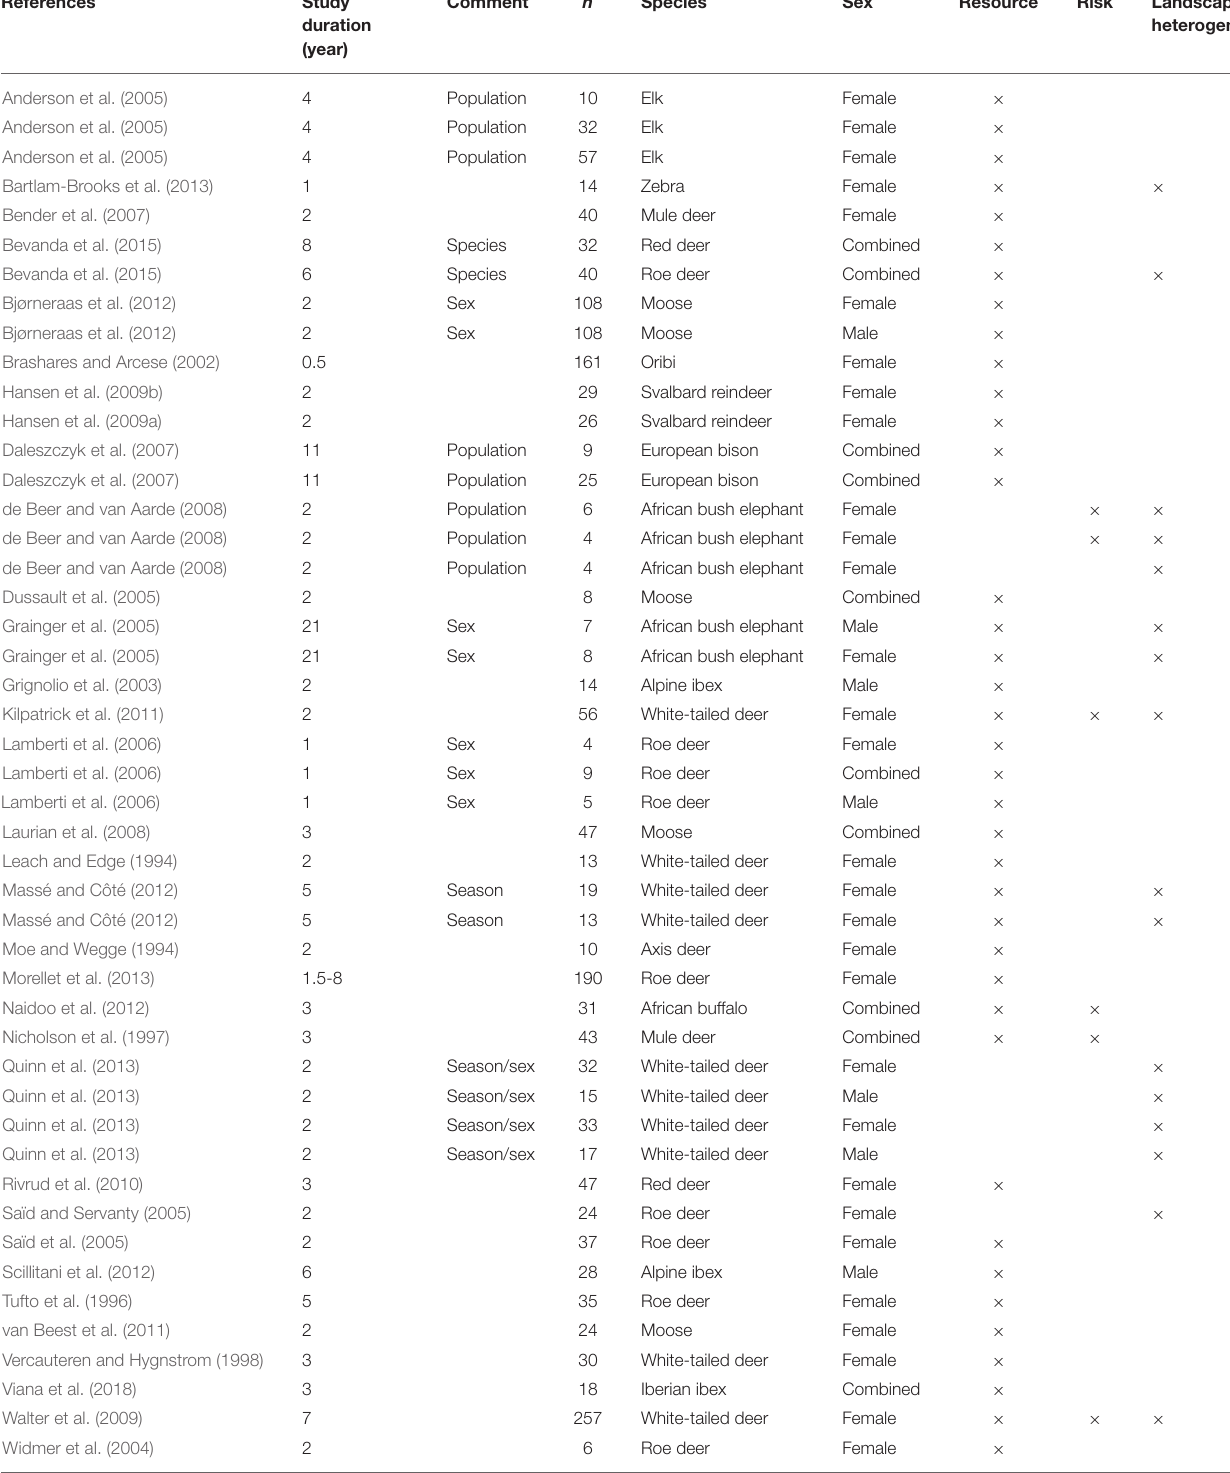
TABLE 1 | Information on the 33 selected papers (productive and non-productive